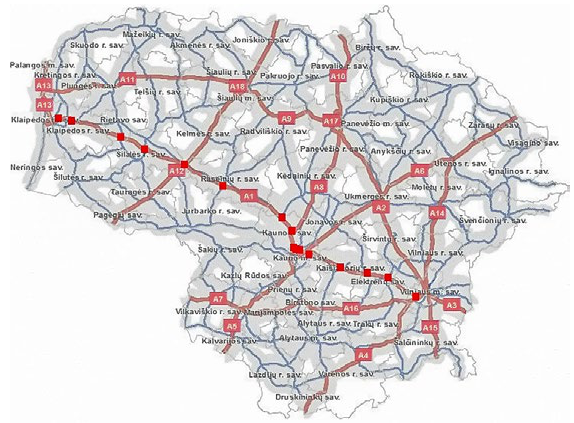
Fig. 6. The arrangement of variable message road